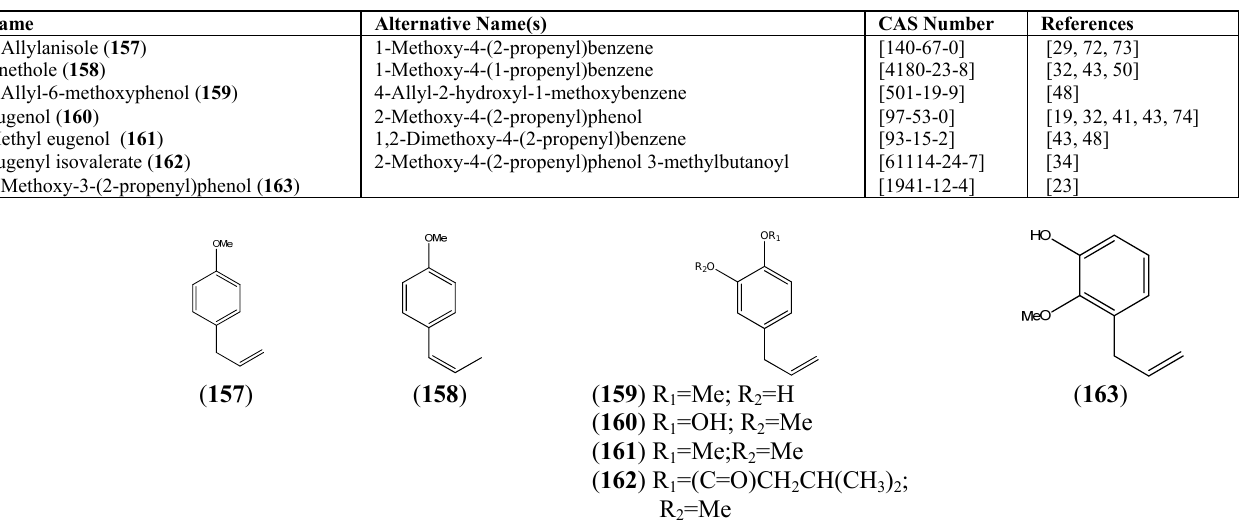
Table 15. Simple Phenylpropanoids.